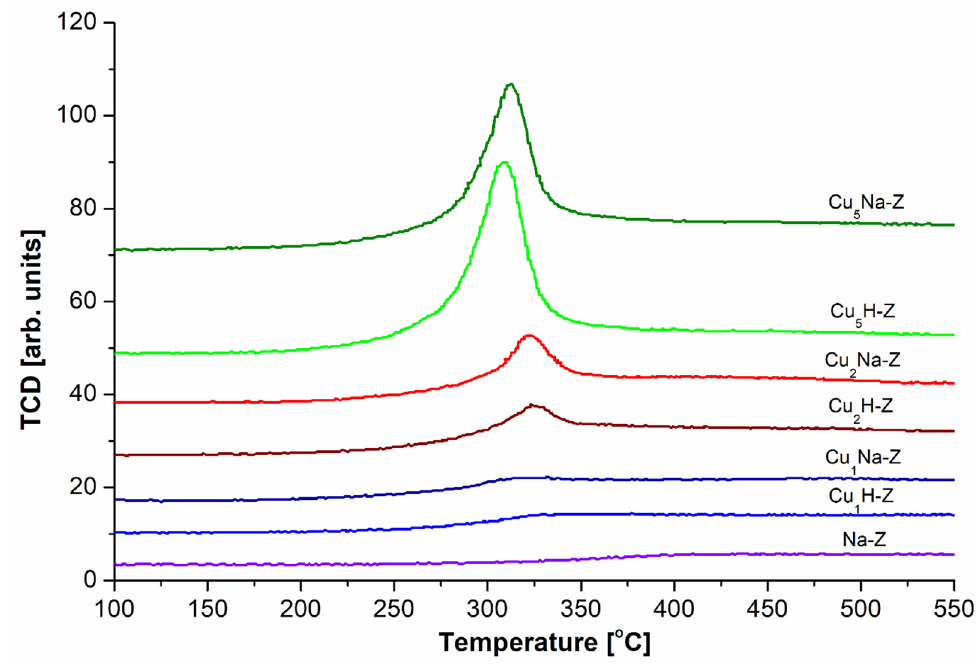
Figure 5. H 2 -TPR profiles for Cu-containing zeolites.